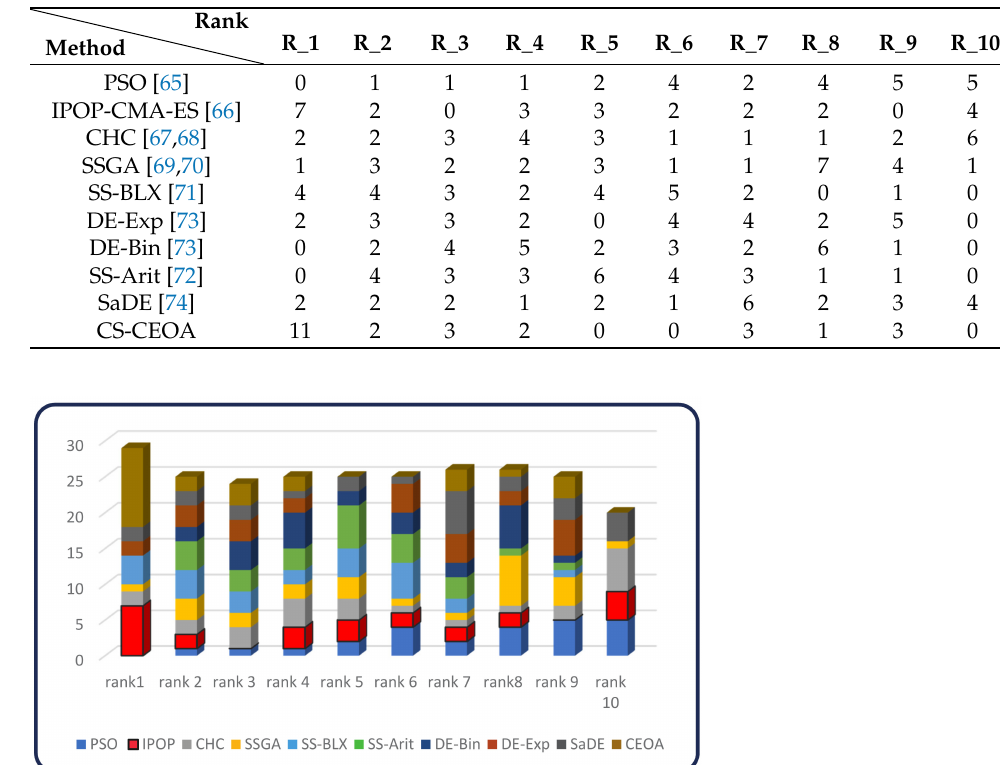
Table 7. Statistical frequency table of ranking values.